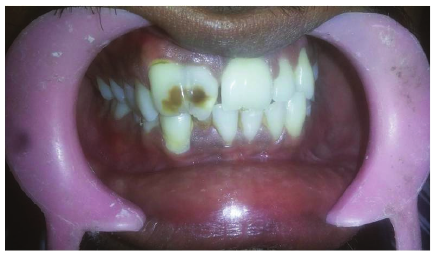
Figure 1: Clinical photograph—before treatment.